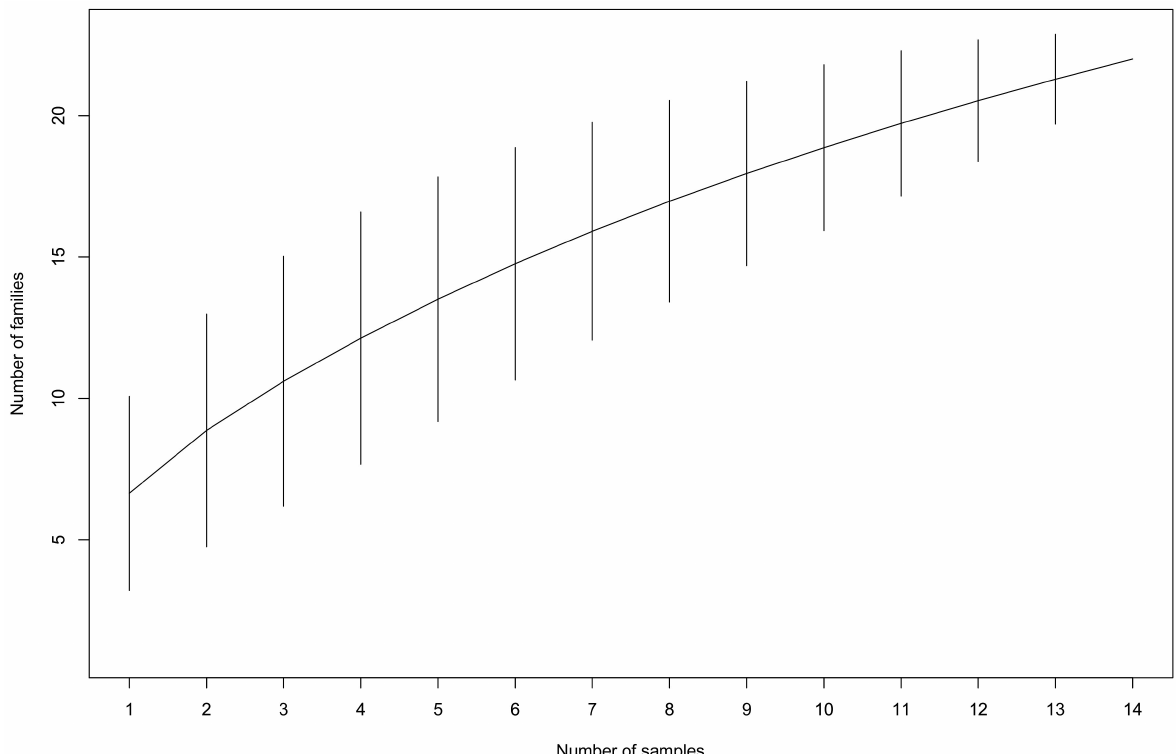
Figure 2. Accumulation curves of viral communities recovered from Hypera postica samples at the family